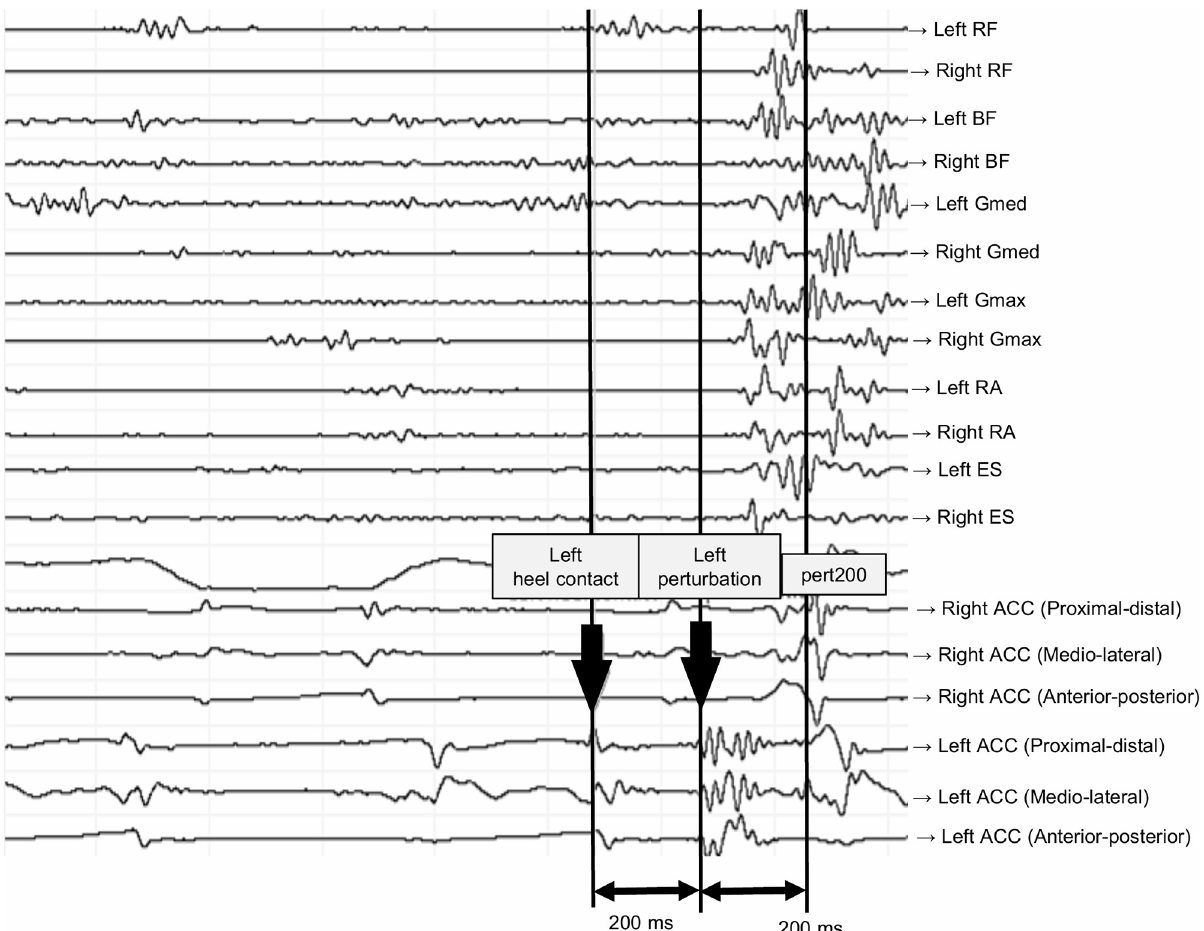
Fig 3. Visualized signals for each recorded muscle and the acceleration sensors in the electromyography analysis software during a left-walking perturbation. Onset of perturbation provoked visible spikes, which assisted the data analyzer in detecting onsets of perturbation. RF: rectus femoris, BF: biceps femoris, Gmed: gluteus medius, Gmax: gluteus maximus, RA: rectus abdominus, ES: erector spinae. ACC: the acceleration sensor. Pert200: 0 to 200 ms after the perturbation in the perturbed walking trail.